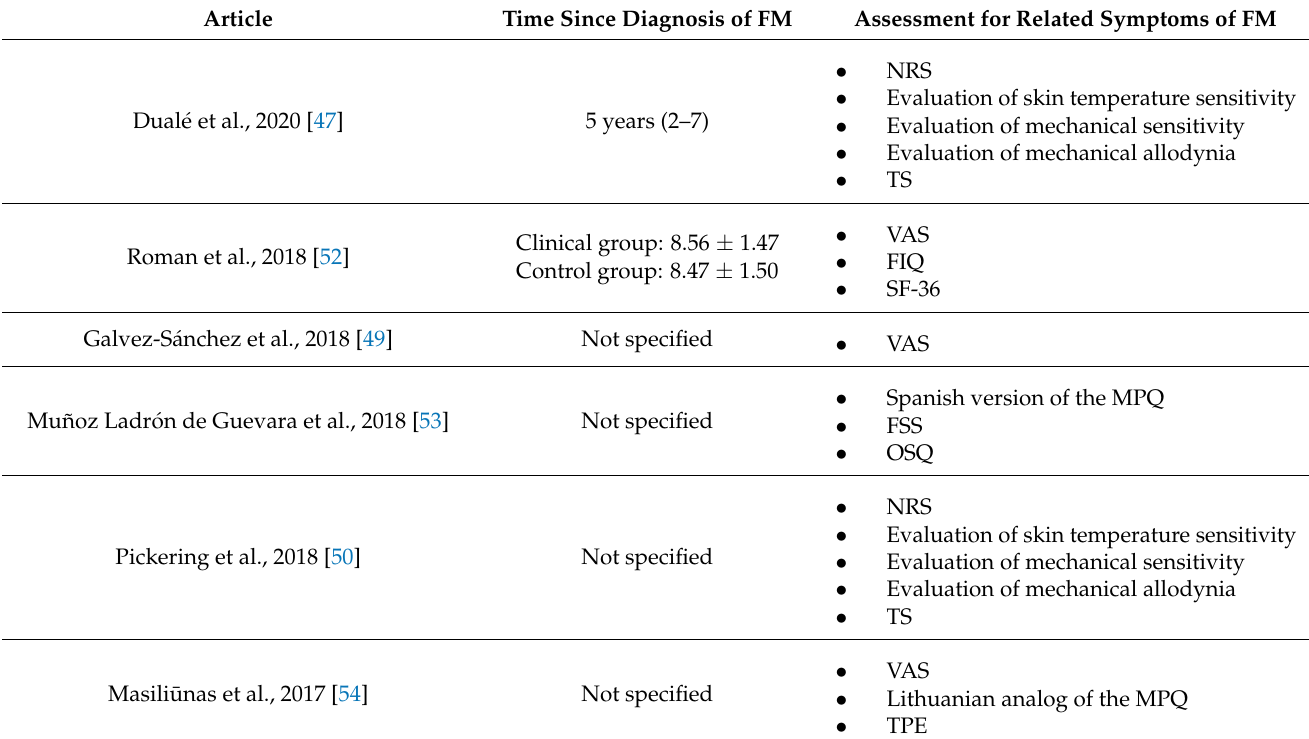
Table 2. Time since diagnosis of FM and assessment for related symptoms of disease. The numerical data are expressed as mean ± SD; the range is shown in